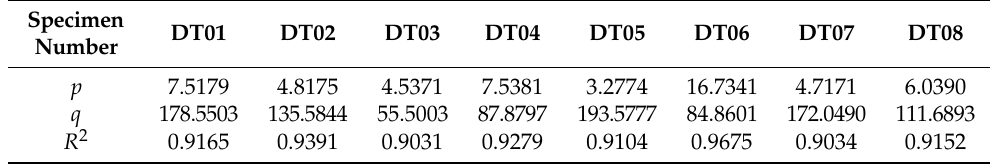
Table 3. Parameters of the proposed model.